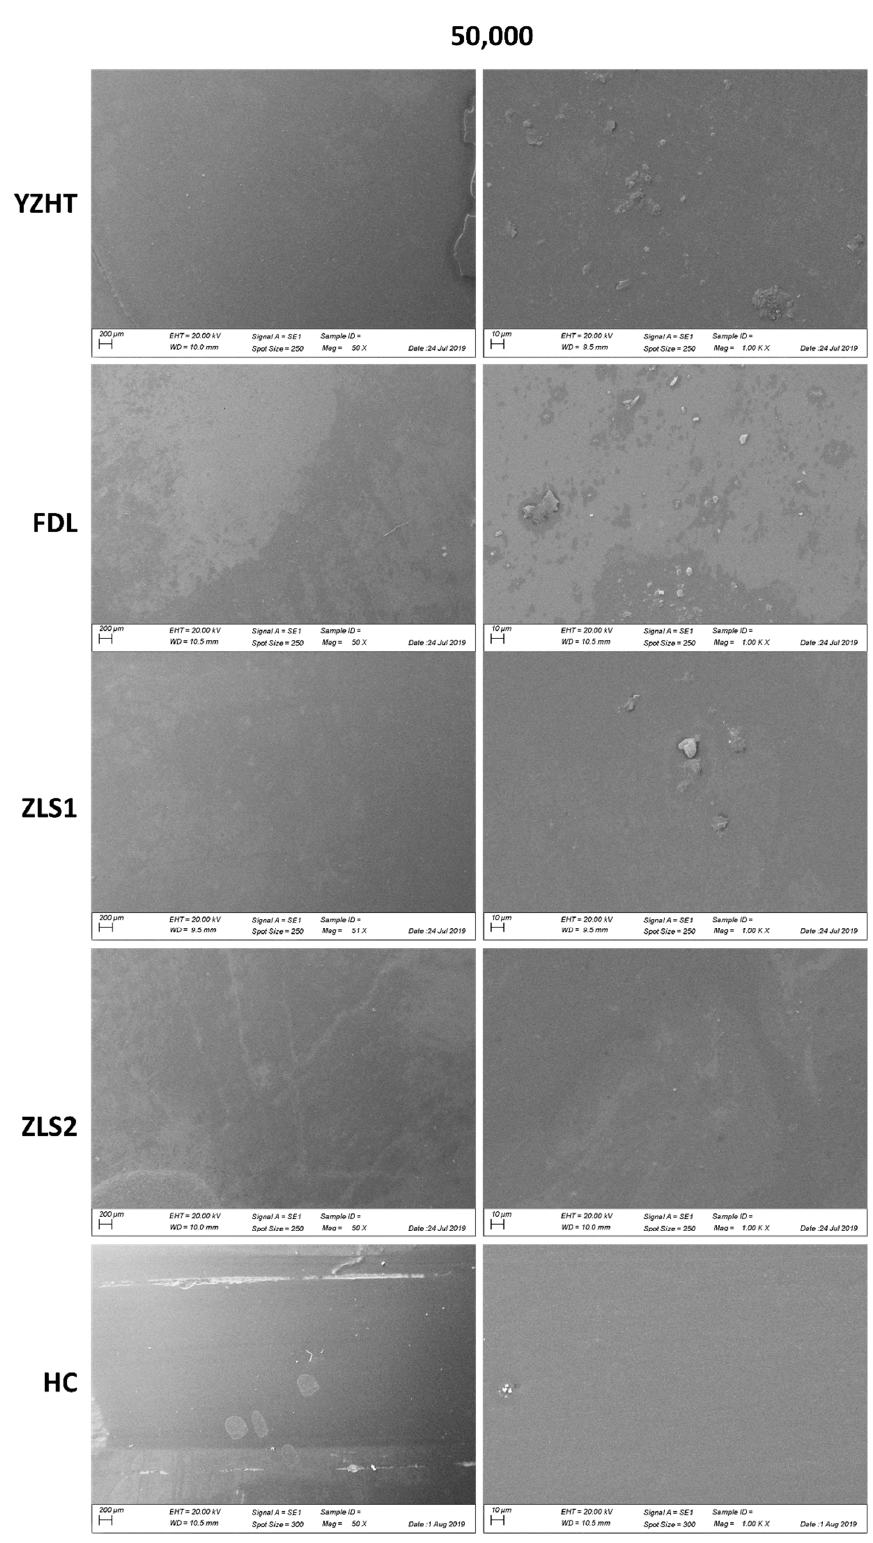
Figure 3. Scanning electron microscopy of surface topography with 50× and 1000× magnification according to the ceramic material (YZHT, FDL, ZLS1, ZLS2 and HC) for 5 years of evaluation.